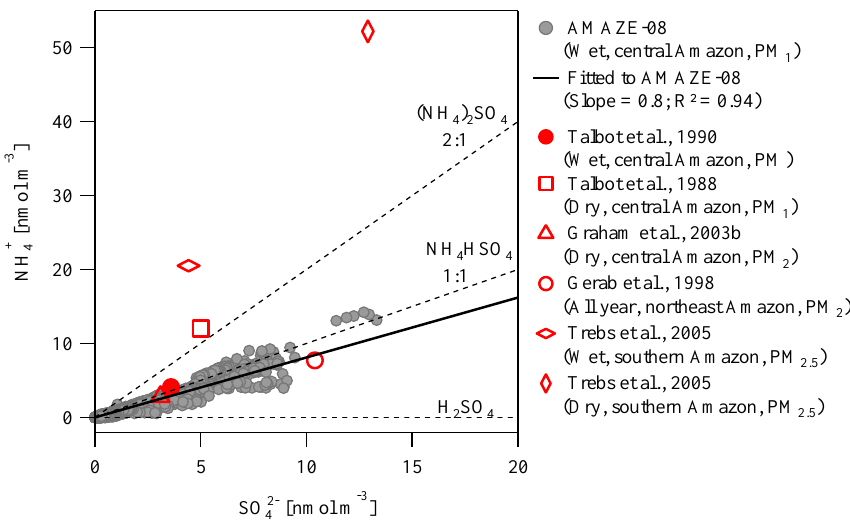
Figure 2. Scatterplot of ammonium and sulfate mass concentrations (gray circles). The red symbols show campaign-average values reported in the literature for other measurements in the Amazon Basin, both in the wet and dry seasons.